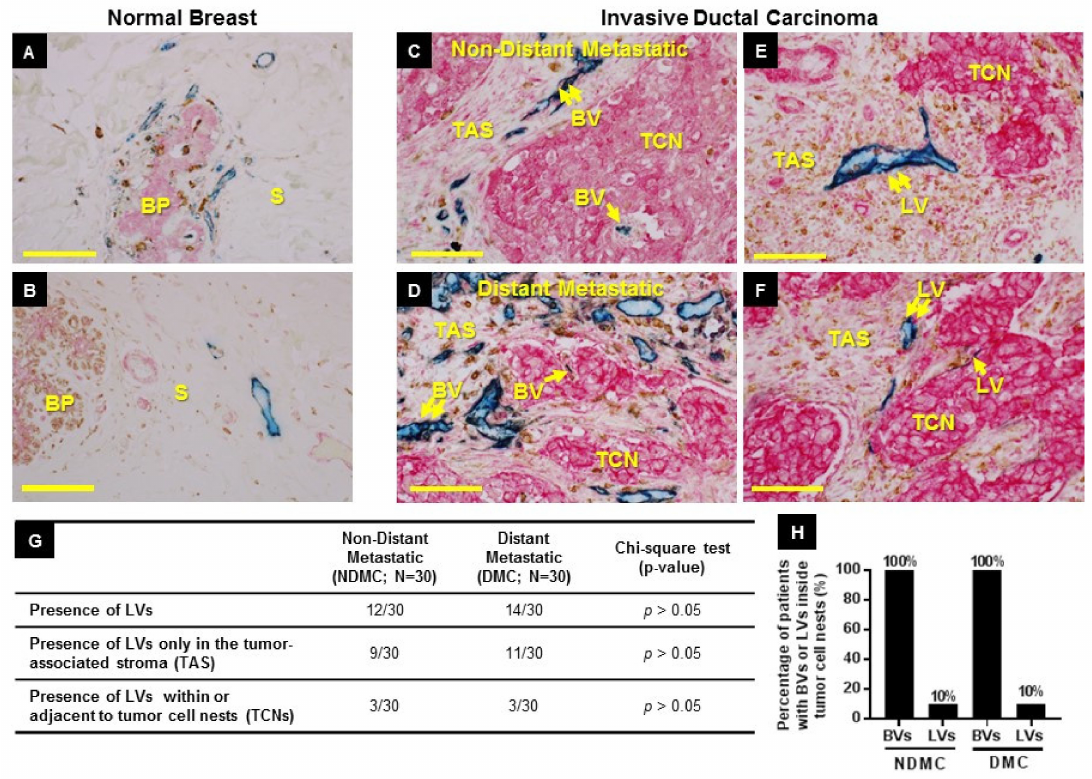
Figure 1. Location of blood vessels (BVs) and lymphatic vessels (LVs) in normal and neoplastic breast tissue. ( A , B ) Normal breast. ( A ) BVs (blue, CD31) are seen in close proximity to the breast glandular parenchyma (BP) as well as in the adjacent connective tissue stroma (S). ( B ) LVs (blue, D2-40) are seen in the stroma (S). ( C – F ) BVs and LVs in primary tumors of patients with metastatic and non-metastatic breast cancer. ( C , D ) In all non-distant metastatic ( C ) and distant metastatic ( D ) cases, BVs are found both in tumor cell nests (TCNs) (single arrow) and in tumor-associated stroma (TAS) (double arrow). ( E , F ) In some cases ( E ), LVs are found only in TAS (double arrow), and only rarely (F) are LVs found both in TAS (double arrow) and in TCNs (single arrow). Scale bars ( A – F ) = 90 µ m. ( G ) Frequency of LV presence in the primary tumors of non-distant metastatic and distant metastatic patient cohorts. ( H ) Percentage (%) of patients with BVs or LVs inside tumor cell nests in the primary tumors of non-distant metastatic and metastatic patient cohort. See Table 2 for panels C – G raw